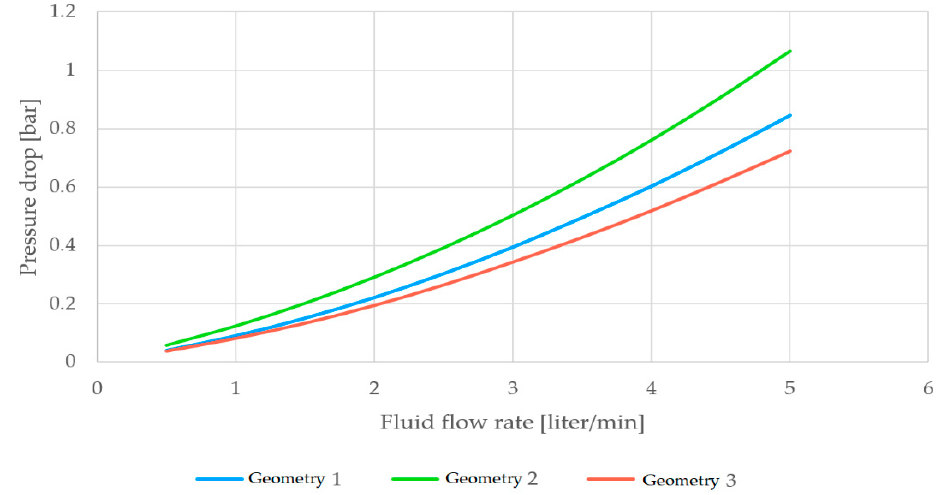
Figure 9. Comparative graph of pressure drops as a function of flow rate and geometry.